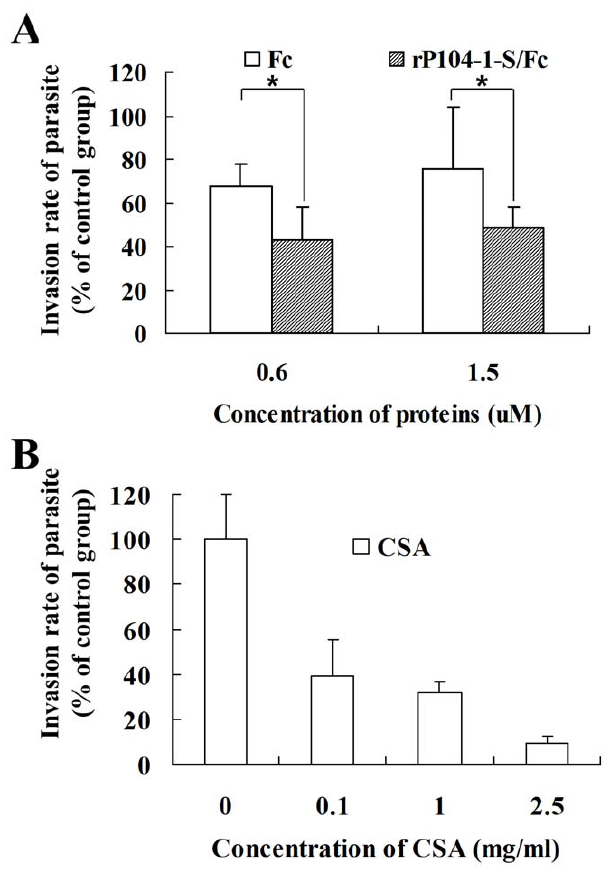
Figure 7. Invitro inhibitory effect of rP104-1-S/Fc or CSA on the invasion of T.gondii . Monolayers of Vero cells in an 8-well chamber slide were infected with 2 6 10 5 GFP-expressing T. gondii after incubation with different concentrations of rP104-1-S/Fc (A) or CSA (B). Extracellular and intracellular parasites were stained differentially and enumerated as described in method section. The invasion rate was calculated as the ratio of parasites/cells in the tested group compared to that in the mock group (Vero cells treated with no protein prior to infection with T. gondii ). Fc was used as a negative control. Student’s t - test, asterisk, P , 0.05; mean 6 standard deviation (n=3